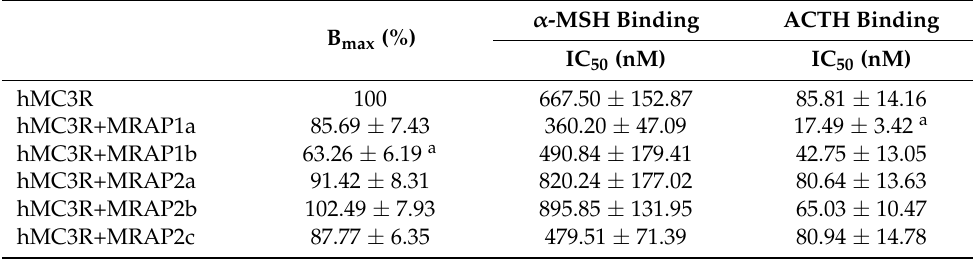
Table 1. The ligand binding properties of hMC3R regulated by hMRAP1s and hMRAP2s.